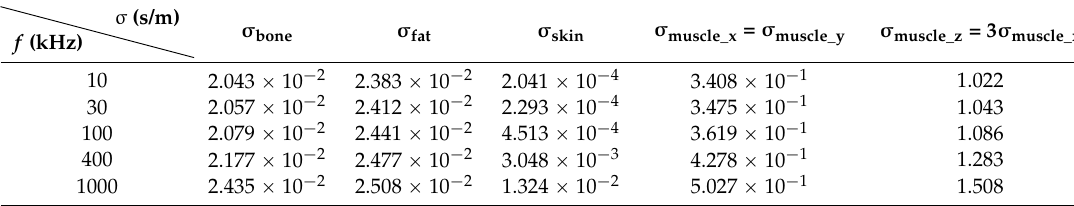
Table 2. The conductivity of tissues at different